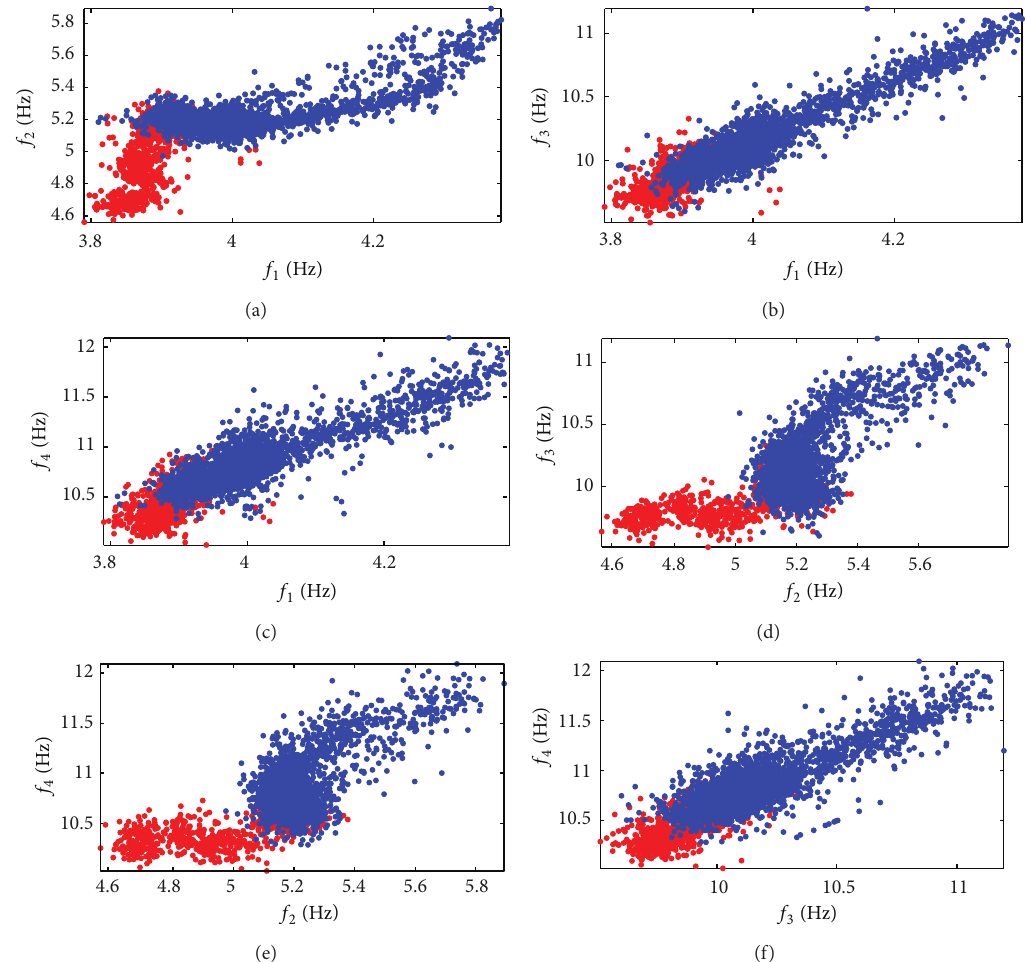
Figure 7: Correlation between the four lowest natural frequencies of the Z24 Bridge. Blue symbols indicate the training data.